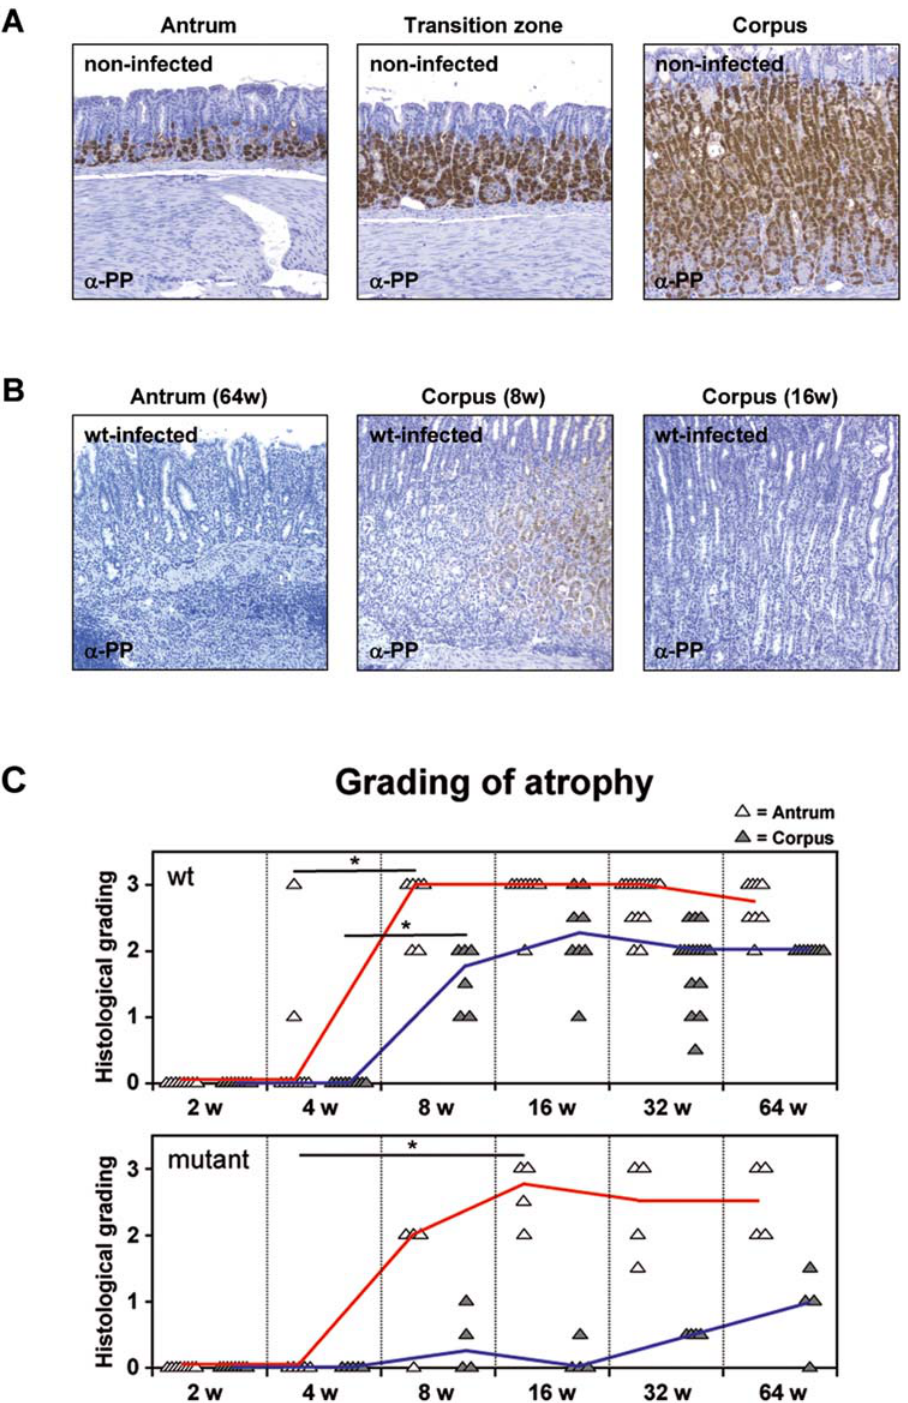
Figure 4. Distribution of parietal cells analyzed by immunohistochemical staining. (A) Parietal cells were detected with anti-proton pump antibody in antral tissue (left panel), transition zone (middle panel), and corpus tissue (right panel) of non-infected Mongolian gerbils (original magnification 10 6 ). (B) Immunohistochemical staining with anti-proton pump antibody detecting complete parietal cell atrophy in antral tissue at 64 weeks (left panel) and beginning at 8 weeks (middle panel) as well as complete parietal cell atrophy in corpus tissue at 16 weeks (right panel) of H. pylori B128 WT-infected gerbils. (C) Histological parietal cell atrophy grading of antral (white triangles) and corpus (gray triangles) mucosa infected with H. pylori B128 WT (upper panel) and B128 D cag Y isogenic mutant strain (bottom panel) over time. (*p , 0.05).